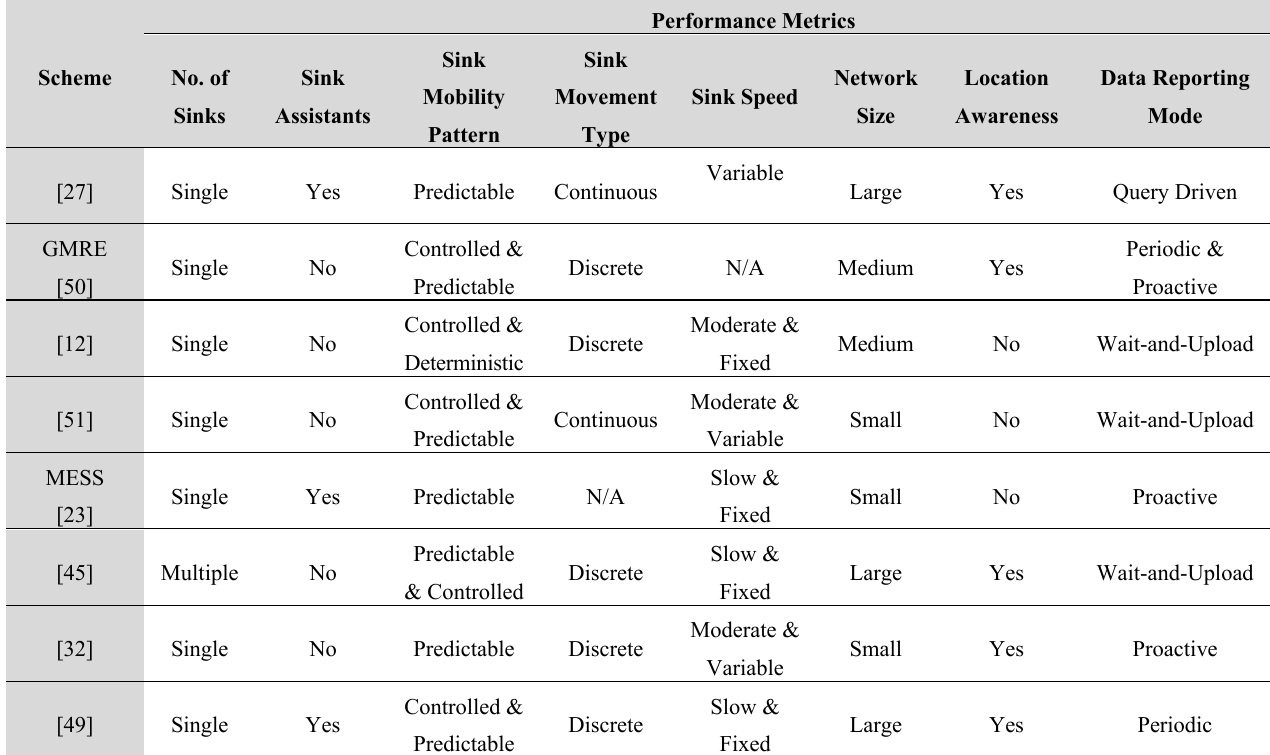
Table 5. Comparative study of data collection/dissemination schemes aiming at data delivery latency.